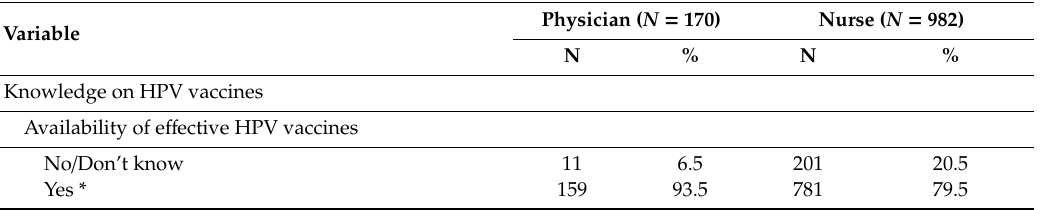
Table 2. Perceptions related to HPV vaccines and intention to take up to HPV